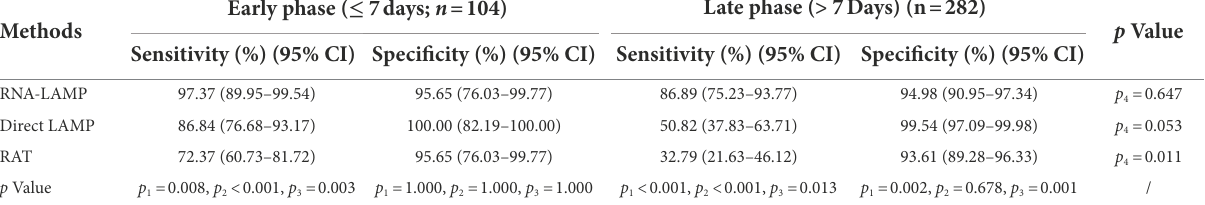
TABLE 4 Performance of LAMP and RAT at the indicated time of collection since first positive RT-qPCR